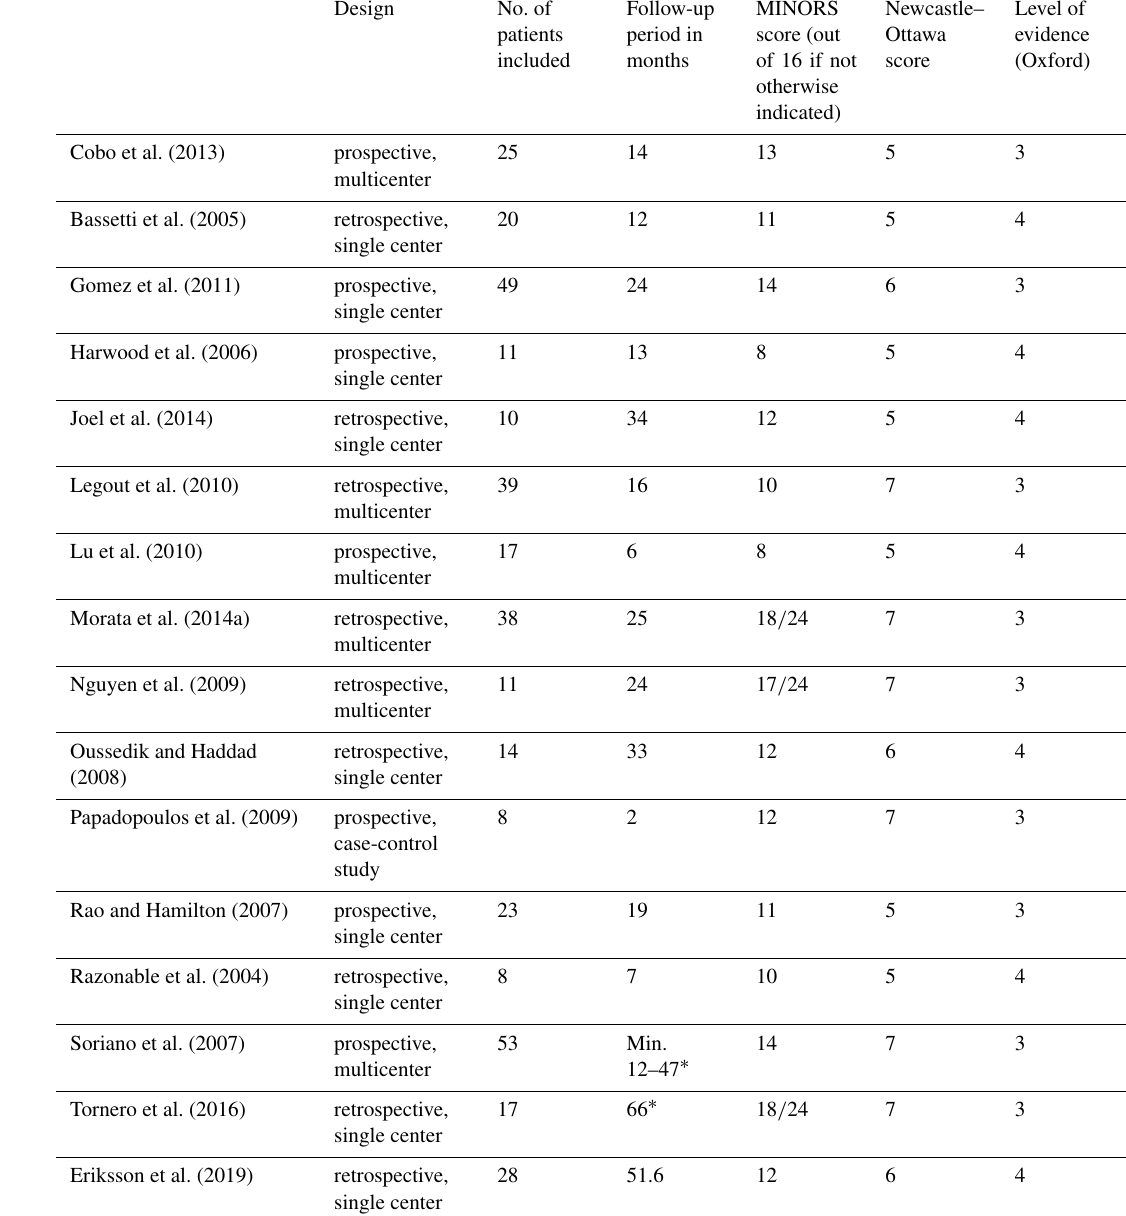
Table 1. Study quality and methodological